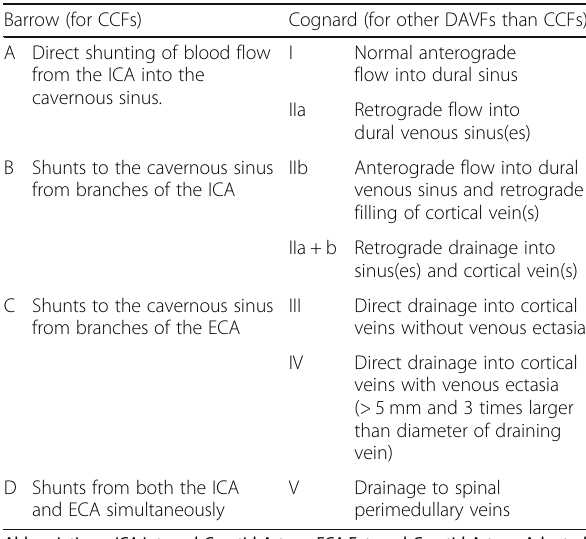
Table 1 Barrow ’ s and Cognard ’ s classifications of